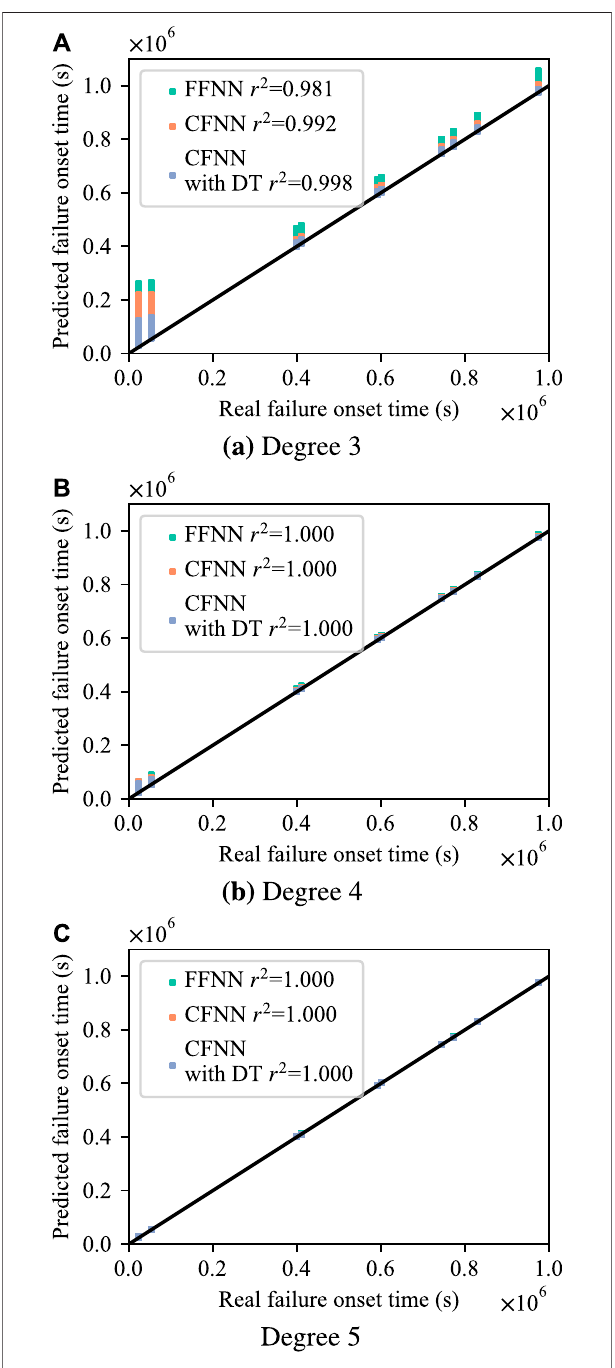
FIGURE 7 | Comparison of response time between the previous FFNN method and the improved method. (A) Degree 3, (B) Degree 4, and